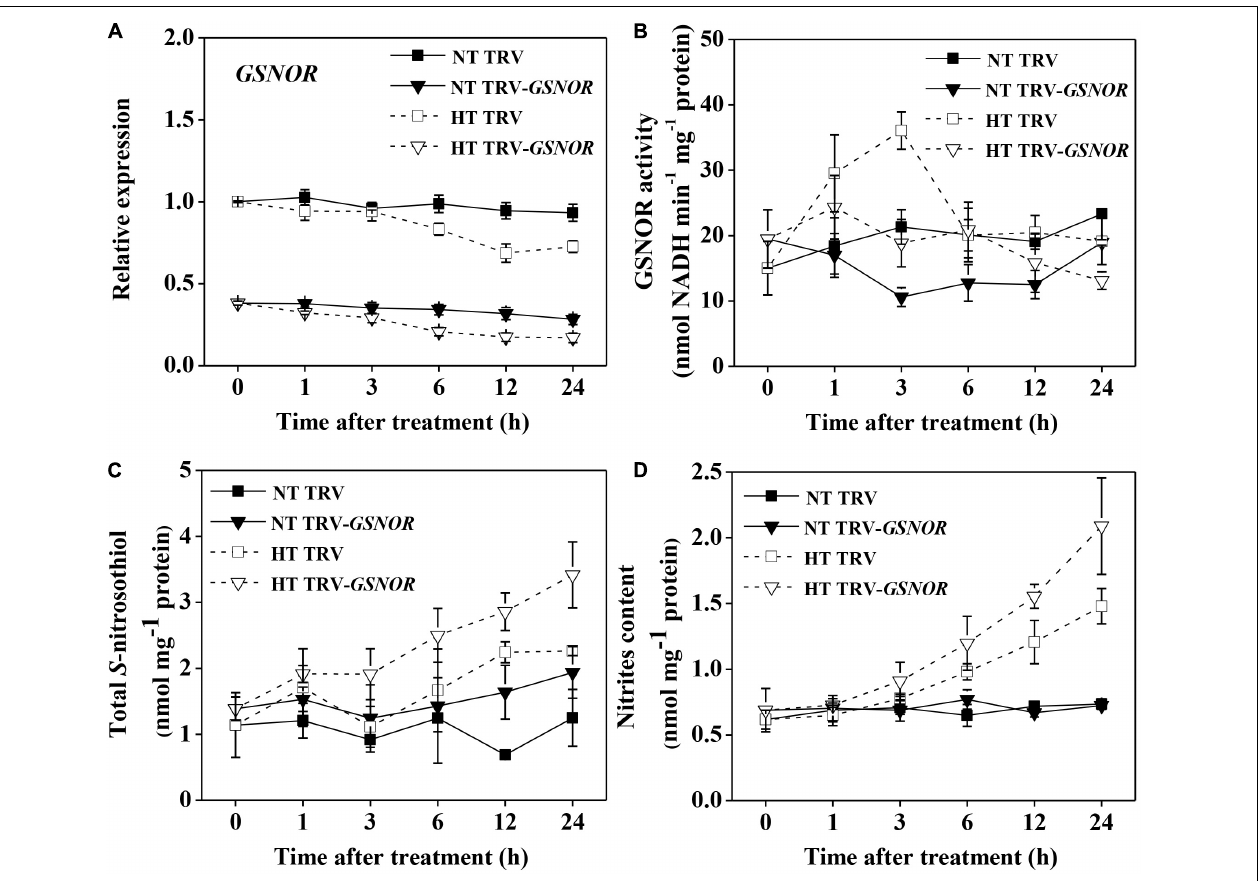
FIGURE 1 | Relative transcript level of SlGSNOR1 (A) , enzymatic activity of GSNOR (B) , total S -nitrosothiol (SNO) content (C) , and nitrites content (D) in SlGSNOR1 -silenced or TRV-empty vector infiltrated plants in response to heat stress. Plants in the five-leaf stage were exposed to high temperature (42 ◦ C/38 ◦ C) or normal temperature (21 ◦ C/16 ◦ C). Data are means of five replicates ( ± SD). NT, normal temperature; HT, high